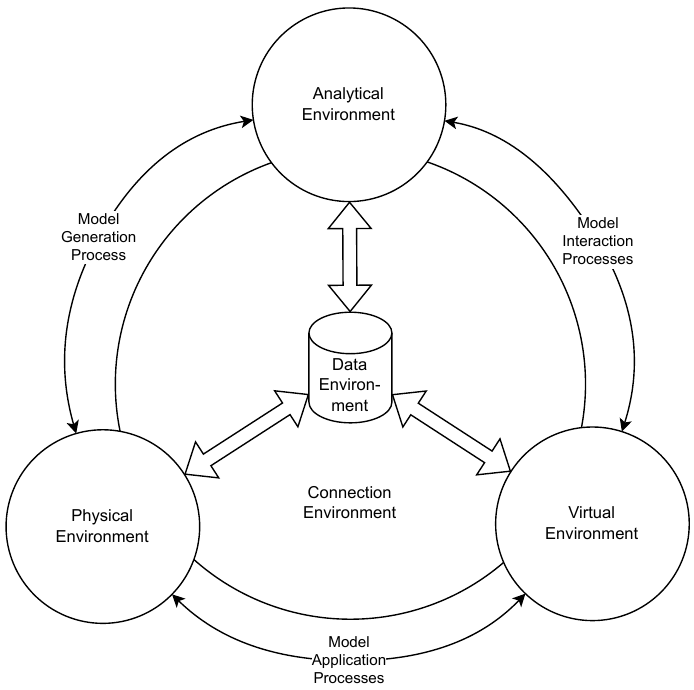
Figure 2. Components of a Digital Twin. A DT is often thought of as the interaction between the PT and the DT [2], but any DT implements five core components, even if only partially. These components are the Physical Environment, the Data Environment, the Analytical Environment, the Virtual Environment, and the Connection Environment [23]. The PT is measured through the Physical Environment of the DT, and the raw data are stored in the Data Environment. The Analytical Environment provides simulations, services and automatisation. Users often only perceive the DT represented in the Virtual Environment as a model of the PT without being aware of the involvement of all the other components. The Connection Environment is the invisible glue that holds the different components together and enables composition with other DTs if properly implemented. Generated with